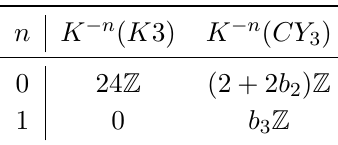
Table 32 . K-groups of CY manifolds, K − n ( K 3) and K − n ( CY 3 ) .